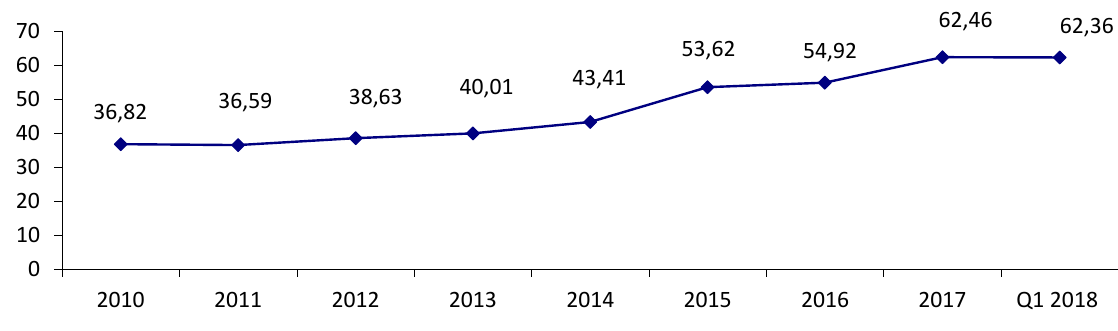
Figure 2. The share of top-5 banks in the aggregate assets